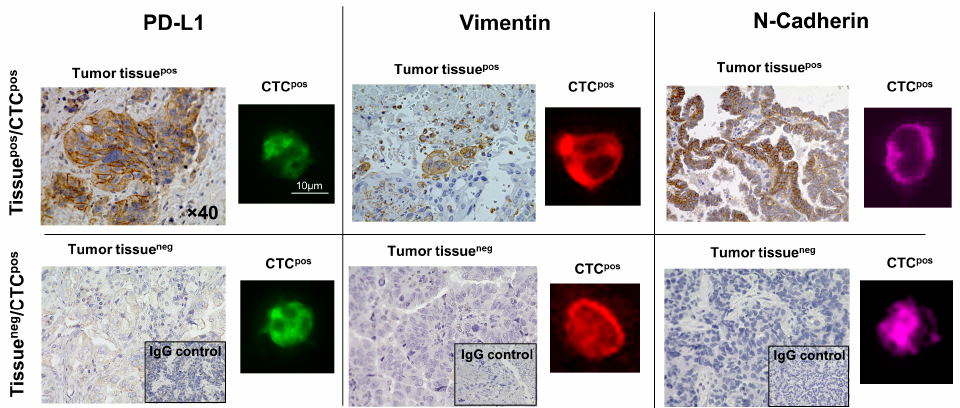
Figure 2. PD-L1 and EMT markers vimentin and N-Cadherin expressions determined by immunostaining in CTCs and patient-matched non-small cell lung cancer (NSCLC) tissues. Shown are representative images of expression patterns of immunohistochemically stained NSCLC tissues and patient-matched CTCs that were stained by immunofluorescence for PD-L1 and EMT markers.